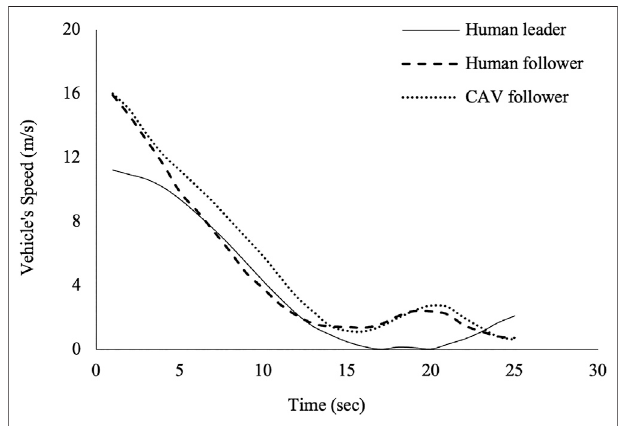
FIGURE 7 | Car-following braking pro fi le generated from the observations and MDP model.